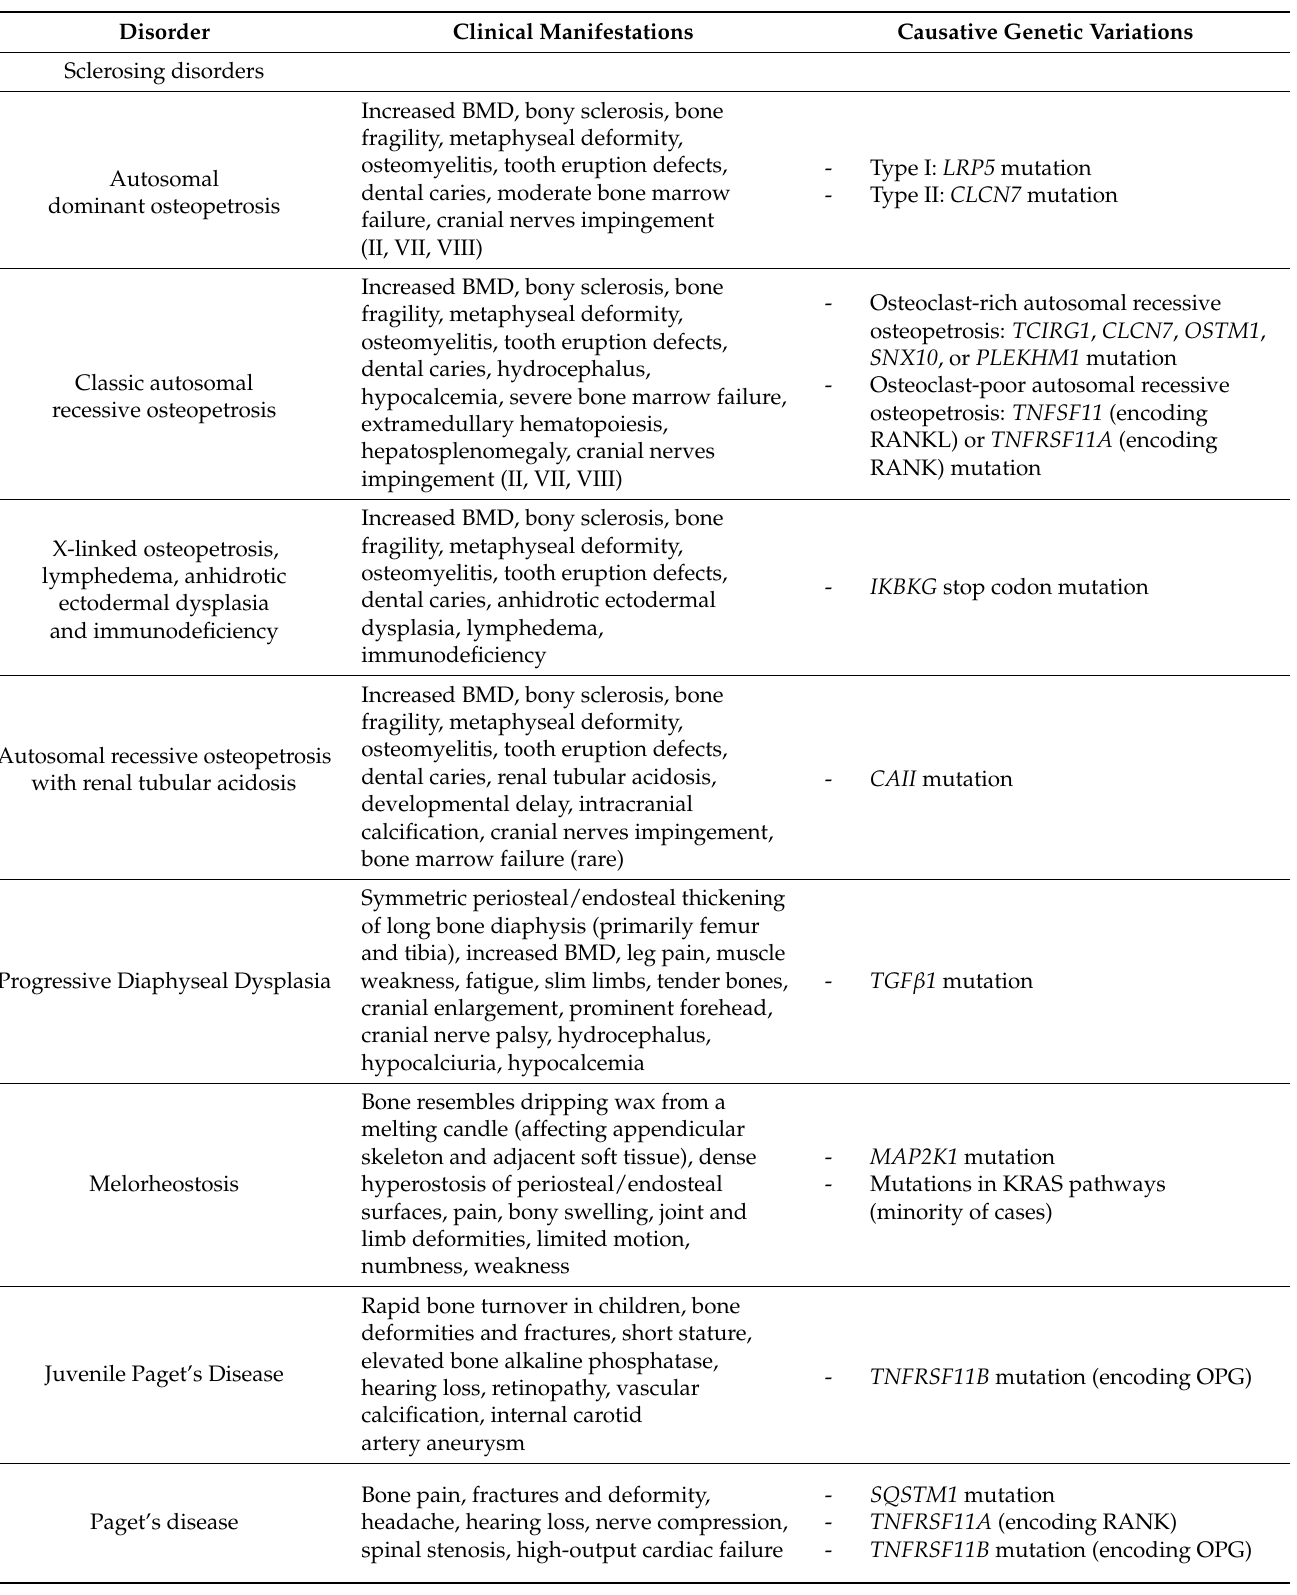
Table 1. Clinical manifestations and causative genetic variations of hereditary metabolic bone